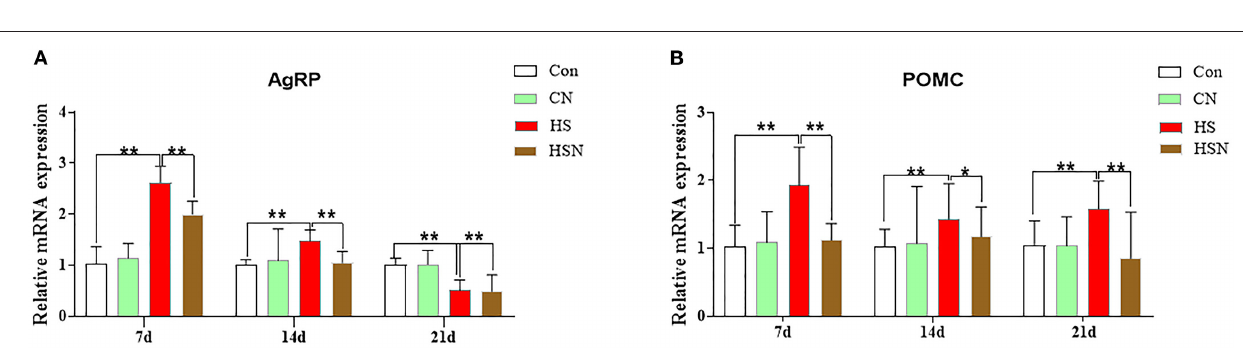
FIGURE 2 | Effects of NAC and heat stress on appetite-related genes expression in the hypothalamus in layers. (A) Expression of AgRP mRNA. (B) Expression of POMC mRNA. * P < 0.01; ** P <